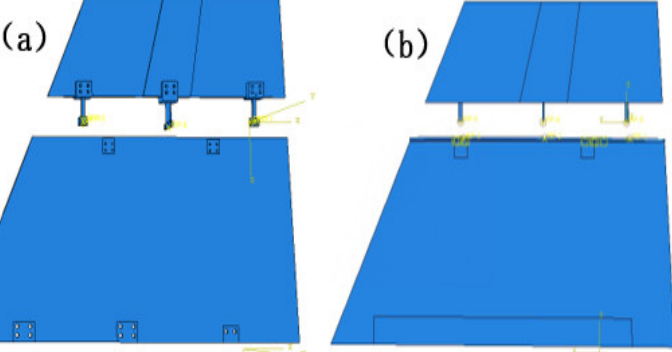
Figure 6. Simplification of finite element model ( a ) simplified model 1, ( b ) simplified model 2.